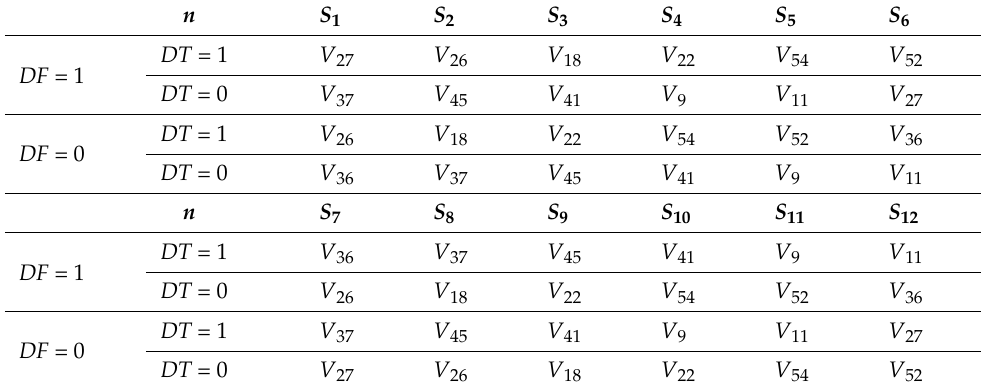
Table 1. Traditional DTC switch table.